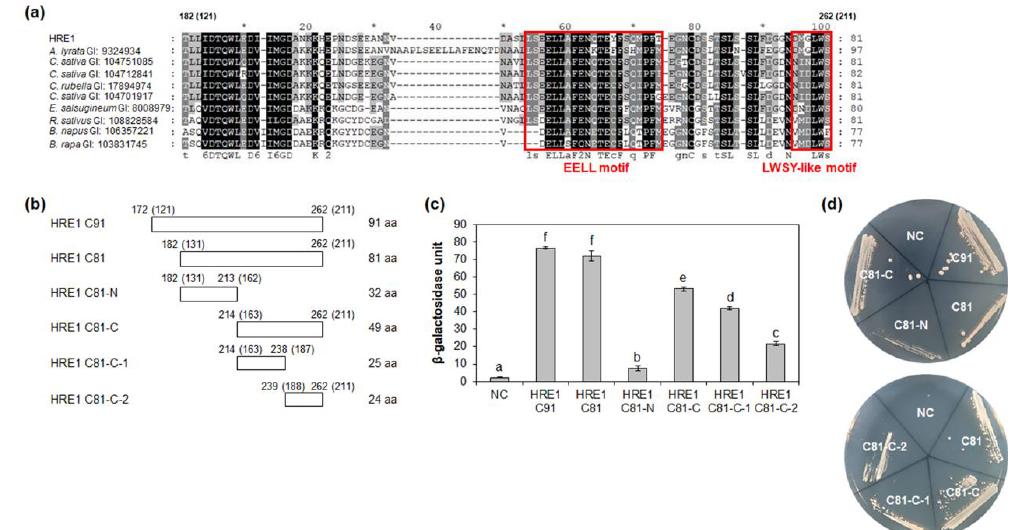
Figure 5. Analysis of transactivation activity of C-terminal region of HRE1β. ( a ) Multiple sequence alignment was carried out with the amino acid sequences of HRE1β C81 and corresponding regions of its orthologs using Clustal Omega. The GI number of each protein sequence is as follows: Arabidopsis lyrata : 9324934; Camelina sativa : 104751085, 104712841, 104701917; Capsella rubella : 17894974; Eutrema salsugineum : 18008979; Raphanus sativus : 108828584; Brassica napus : 106357221; Brassica rapa : 103831745. The EELL motif and LWSY-like motif are represented as boxes. ( b ) The schematic maps of HRE1β C91 and C81, and partial fragments of C81 for the analysis of transactivation activity in yeast. The numbers in parentheses represent the position in HRE1α. ( c ) Quantitative β-galactosidase ONPG assay. The transactivation activities were quantified by measuring the β-galactosidase activity in yeast extract. The experiments of each technical replicate were performed in triplicate. The data shown are the means ± S.D. ( n = 3). Similar results were obtained from at least three biological replicates, with one shown here. The data were analyzed with one-way ANOVA using Tukey’s multiple comparison test. Different letters indicate significant di ff erences ( p < 0.05). ( d ) Yeast growth assay. Yeast